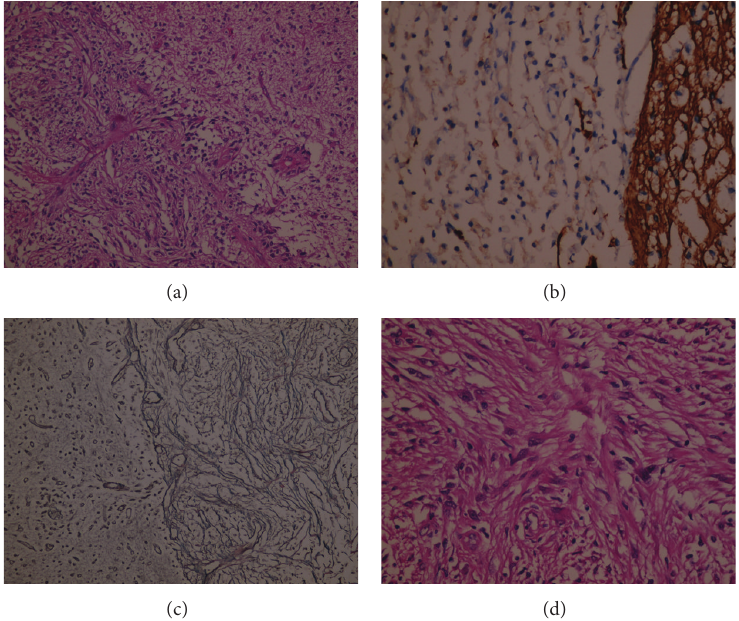
Figure 2: Pathological images of the lesion (a) gliosarcoma. A biphasic tissue pattern with areas displaying gliomatous and mesenchymal differentiation (H&E stain, original magnification ×200 ). (b) The gliomatous component shows strong GFAP expression and is separated from mesenchymal tumour cells without GFAP expression (immunoperoxidase stain, original magnification ×400 ). (c) Dense reticulin network shows that the sarcomatous area is well demarcated from the glial tumour portion (reticulin stain, original magnification ×200 ). (d) Sarcomatous area consisting of spindled and pleomorphic cells arranged in a storiform pattern (H&E stain, original magnification ×400